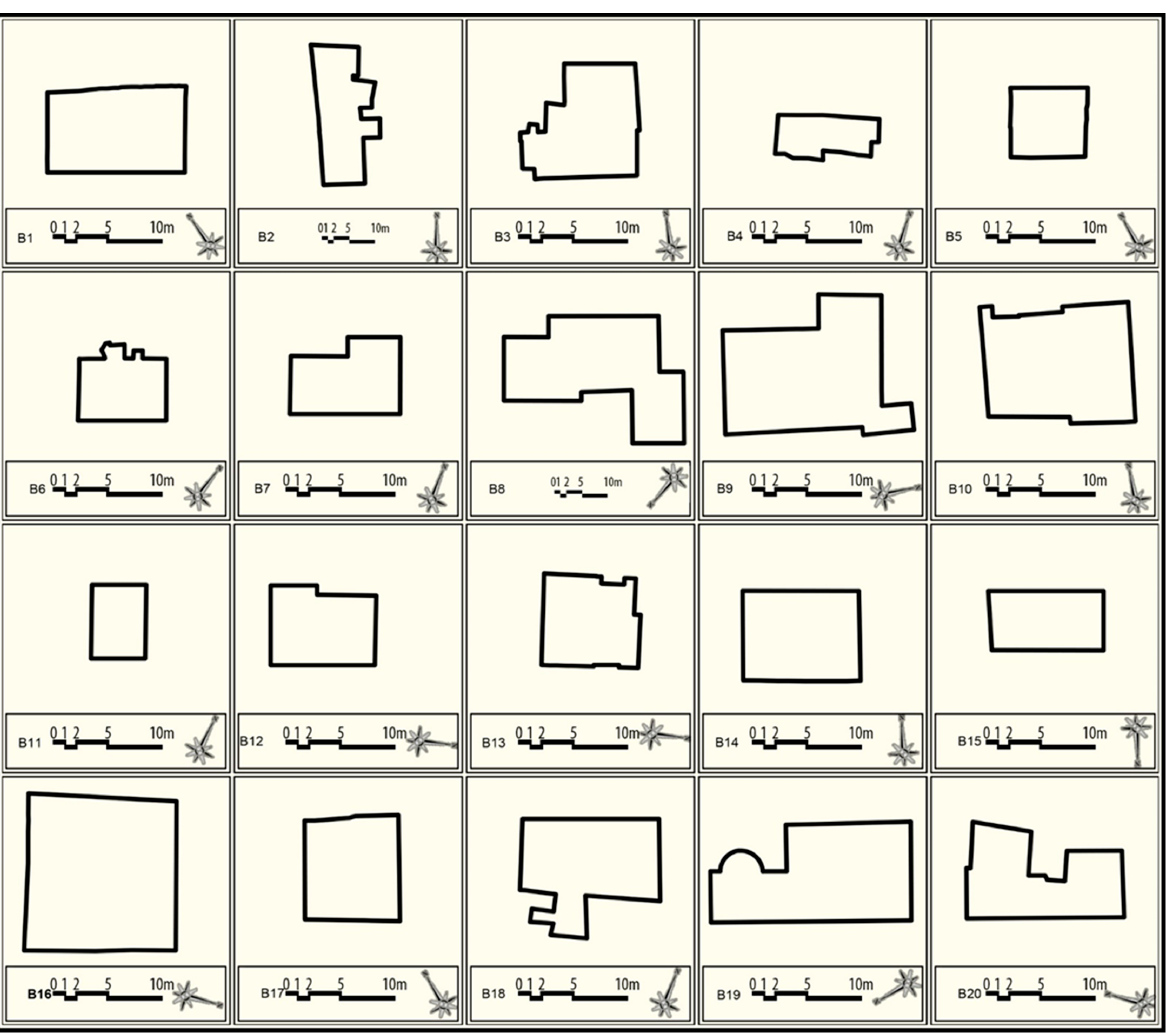
Figure 18. The ground floor plans of the examined masonry structures.